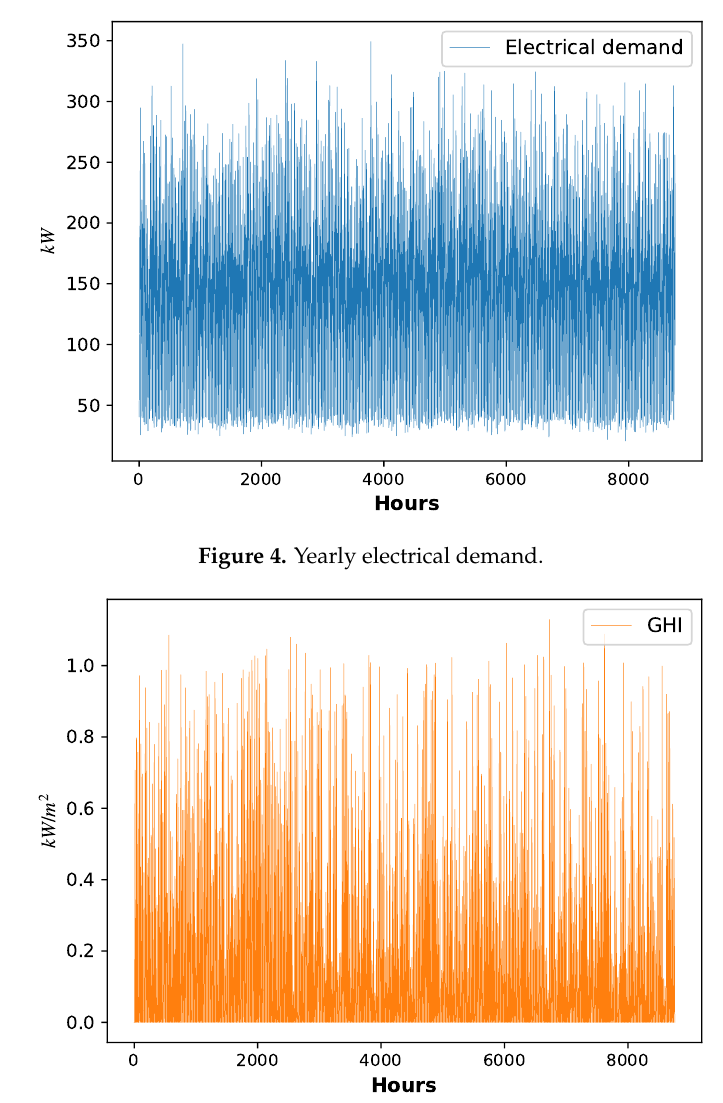
Figure 5. Yearly Global Horizontal Radiation.